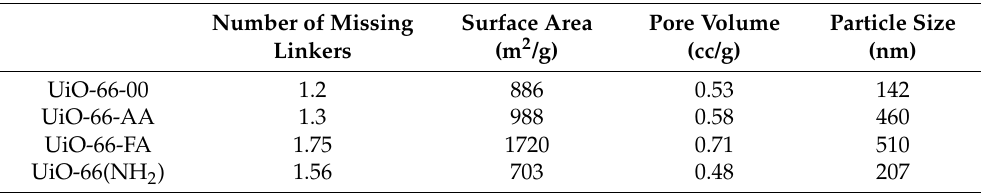
Figure 2. SEM images for the synthesized MOFs at a 1 μm and 500 nm scales; ( a , b ) for UiO-66-00, ( c , d ) for UiO-66-AA, ( e , f ) for UiO-66-FA, ( g , h ) for UiO-66(NH 2 ). Table 1. Textural properties of the synthesized MOFs.